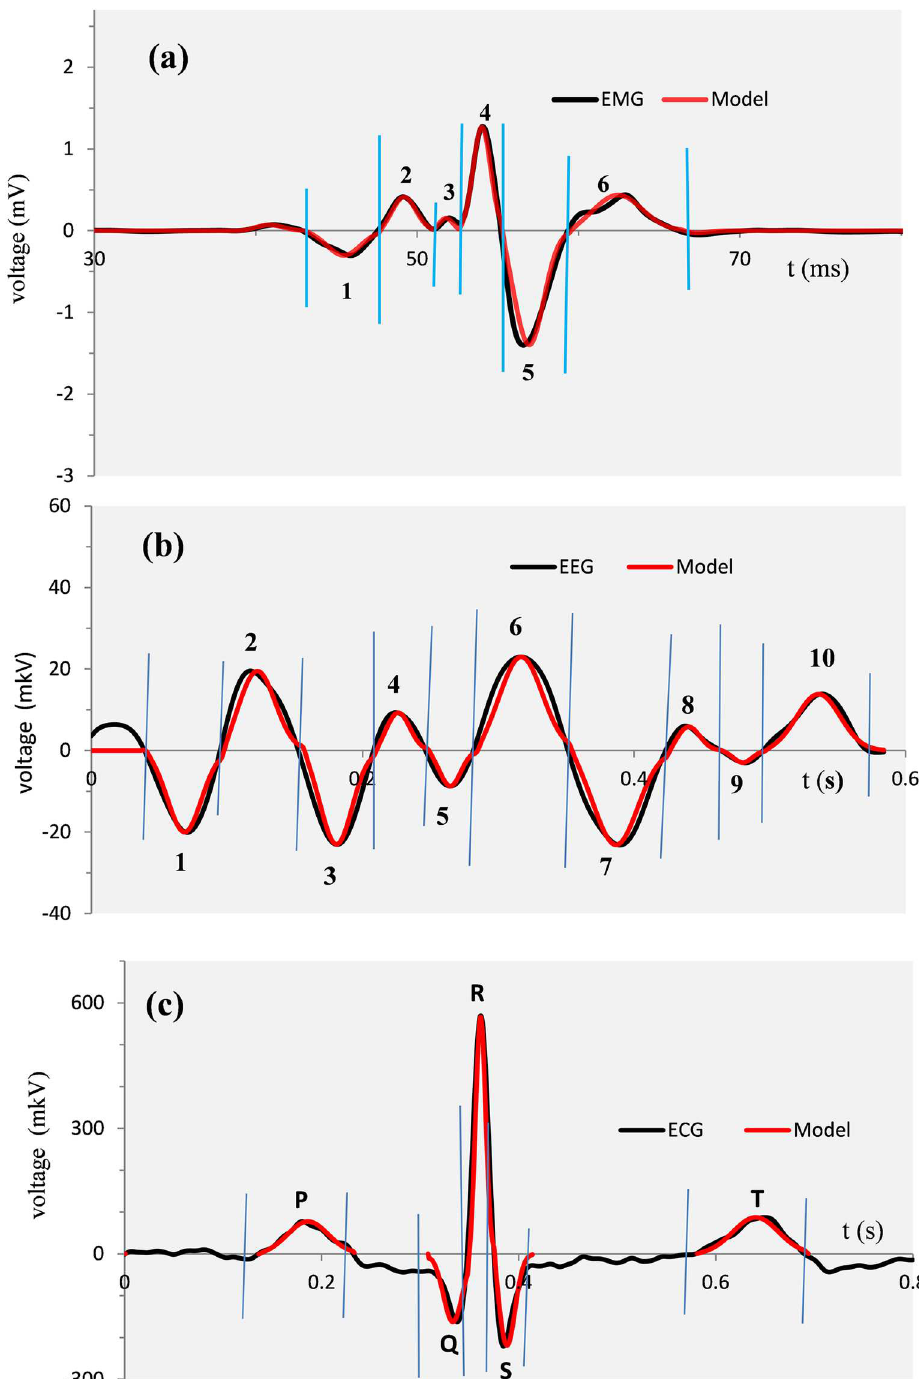
Fig 10. Models of typical mass potentials with parameters τ, κ , σ, and β listed in Table 1. (a, b) Black lines show typical records of eye-blink EMG and EEG. Vertical blue lines indicate the segmentation points. The red lines are the models calculated from Eq (22) as the sums of models created for each empirical half-wave (signal fragment between adjacent segmentation points). (c) The same illustration of results as in (a) and (b), except that models are only shown for P, Q, R, S, and T ECG